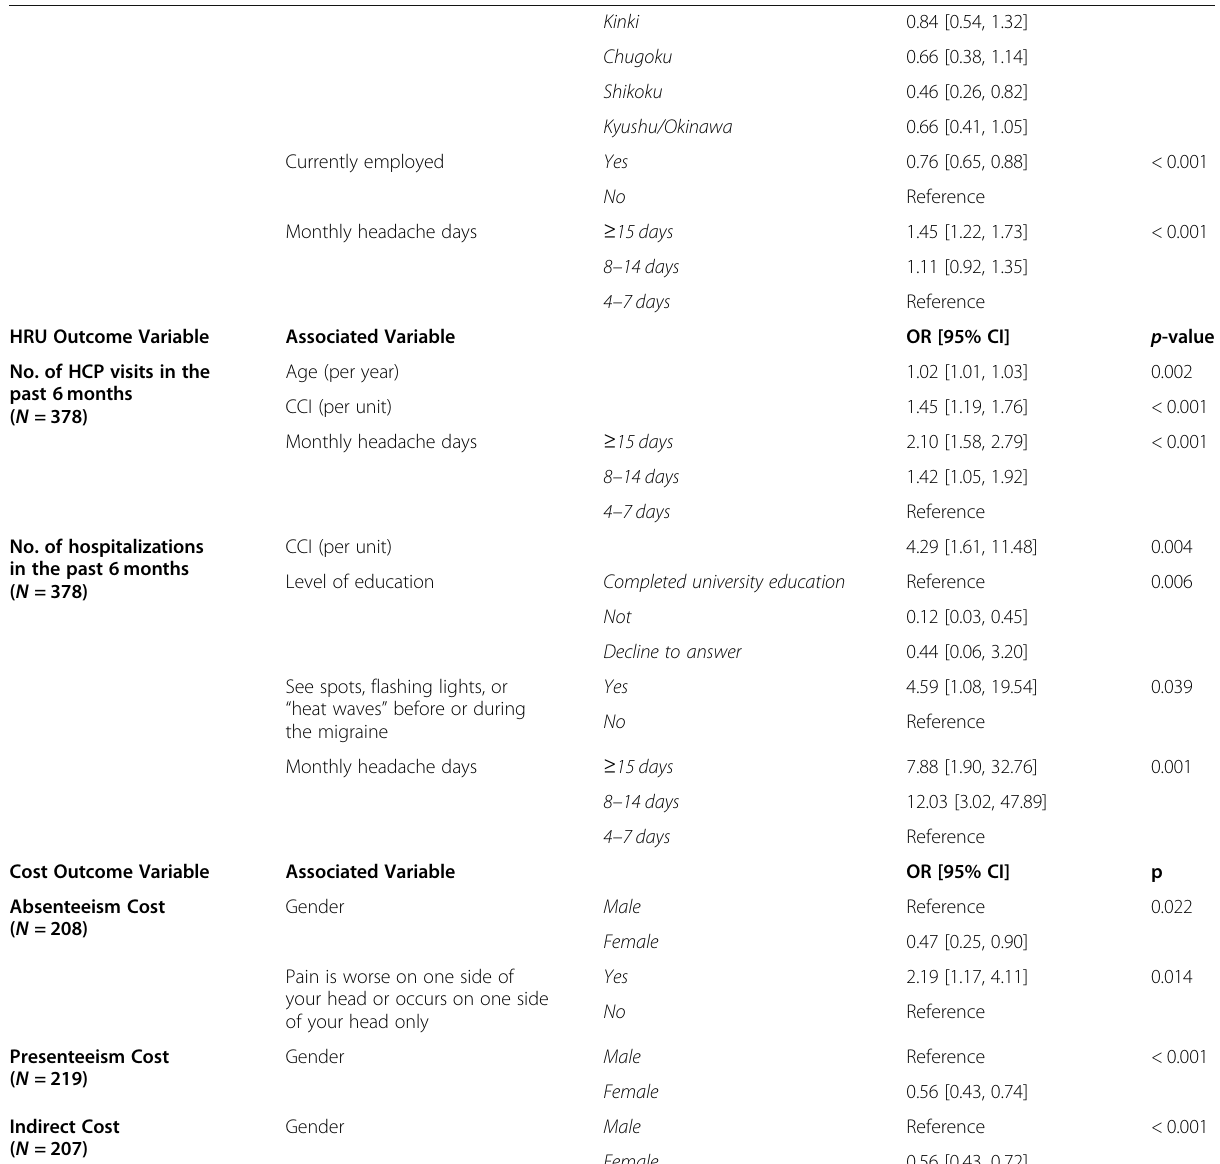
Table 2 Multivariate analyses of factors associated with humanistic and economic burden among Japanese migraine patients